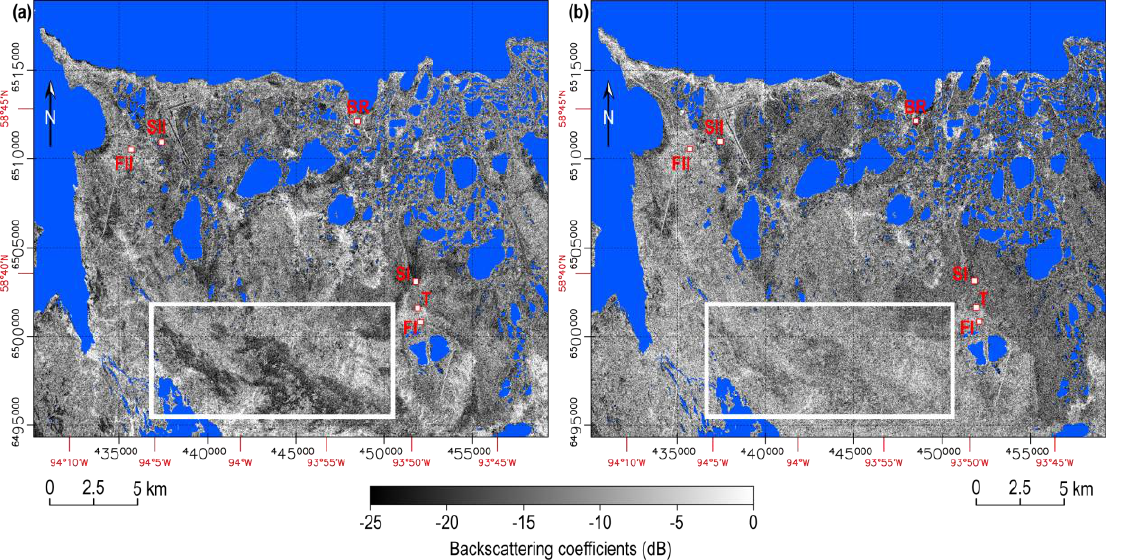
Figure 2. A comparison of the two RADARSAT-1 images acquired in standard beam mode 1 during the period of peak snow accumulation for the winters of ( a ) 1997/98 and ( b )